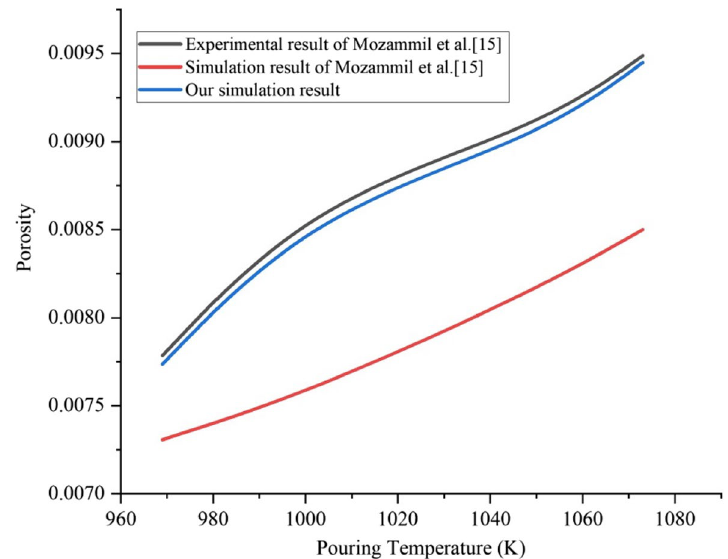
Fig. 3 Comparative analysis of porosity vs pouring